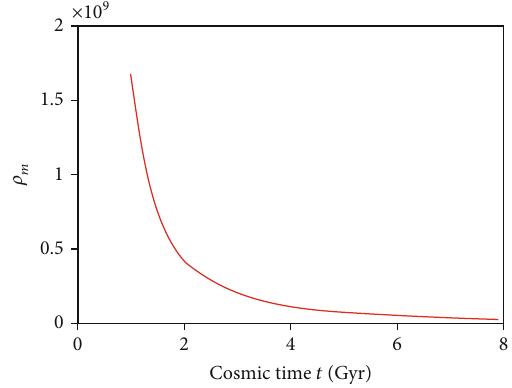
Figure 3: The plot of energy density of dark matter versus cosmic time t for constants l = 1 : 5 , n = 2 , α = 0 : 5 , k = 0 : 5 , m = 0 : 6 .